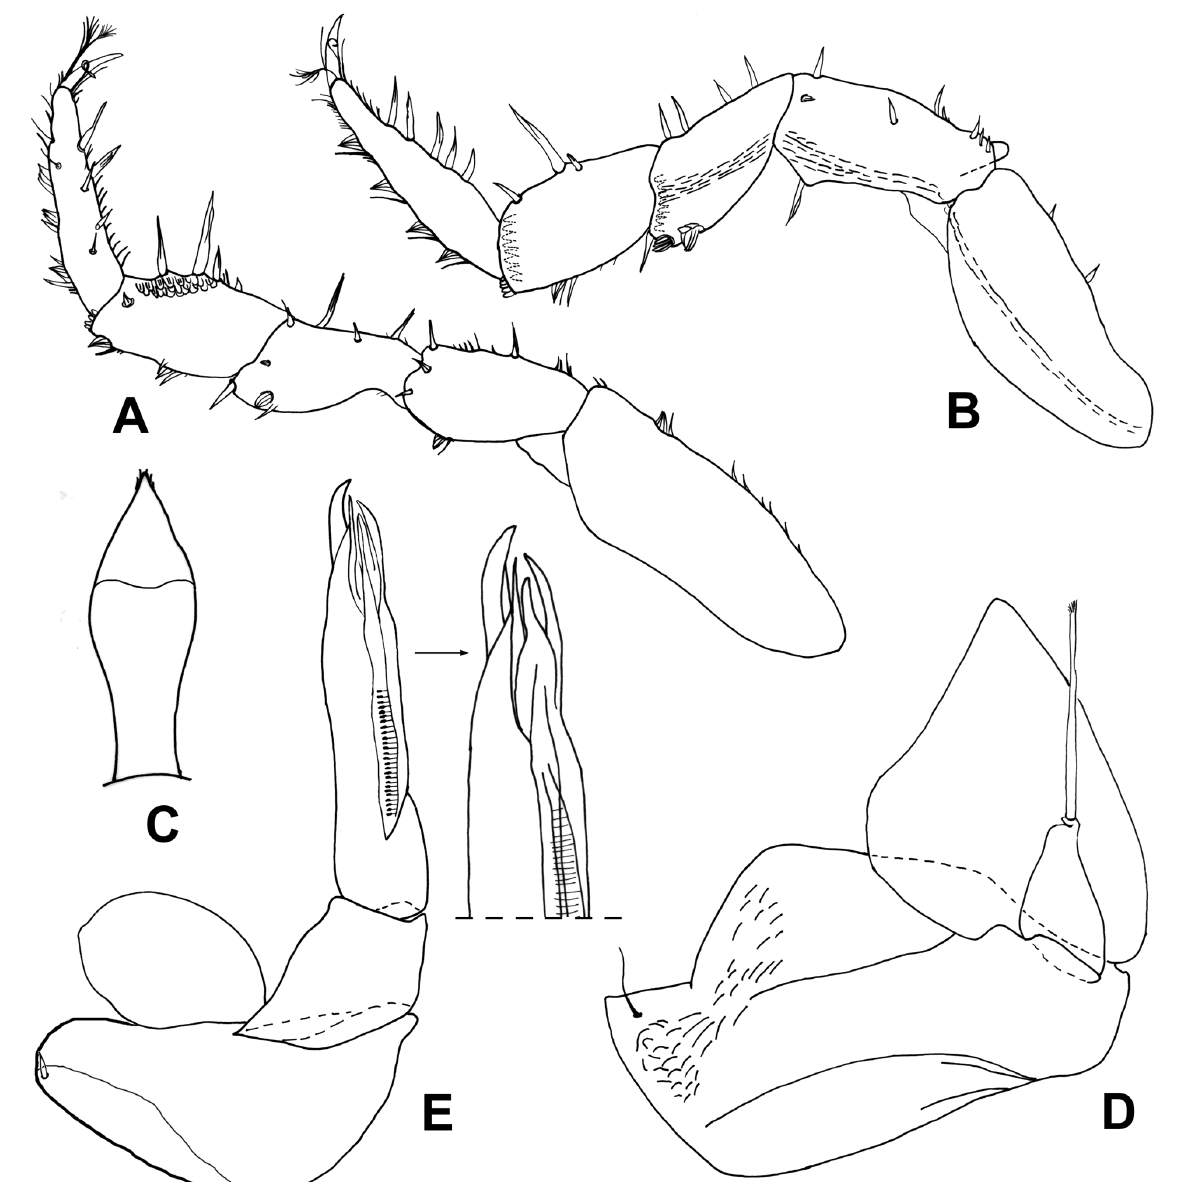
Fig. 25. Cordioniscus lusitanicus Reboleira & Taiti sp. nov. from Algar de Santo António, Estremoz- Cano, paratype, ♂. A . Pereopod 1. B . Pereopod 7. C . Genital papilla. D . Pleopod 1. E . Pleopod